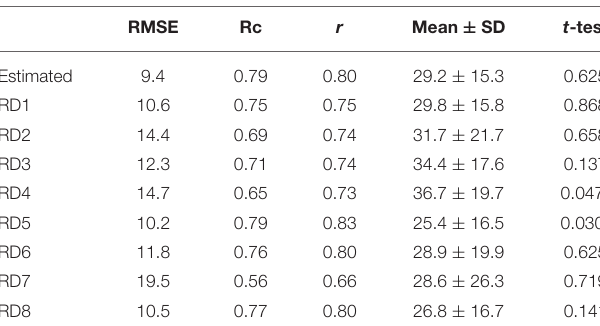
TABLE 1 | Statistical results for the estimation of error, agreement, and relationship as measured by RMSE, Rc, and r , respectively, between estimated and RDs of carbohydrate against measured in the validated